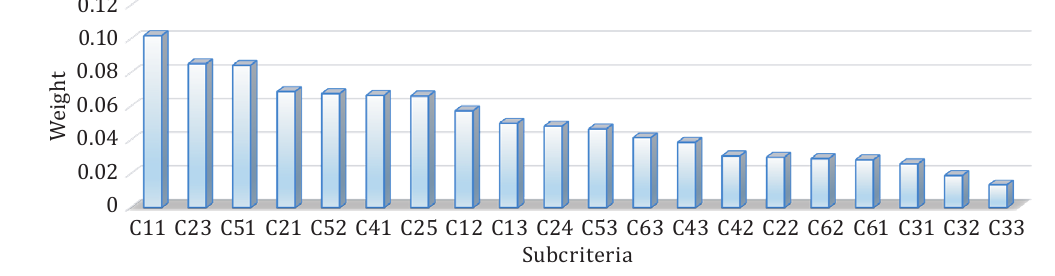
Figure 2. Priority of uncertain